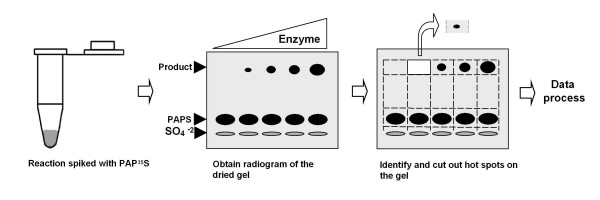
Scheme of electrophoresis based sulfotransferase assay. The assay mainly consists of four steps. First, spike sulfotransferase reaction with PAP35S. Second, separate the reactions on 8% SDS gel by electrophoresis and obtain an autoradiogram of the dried gel. Generation of the free sulfate is inevitable due to the degradation of PAPS. Third, cut out the hot spots on the dried gel and count the radioactivity. Fourth, data process.